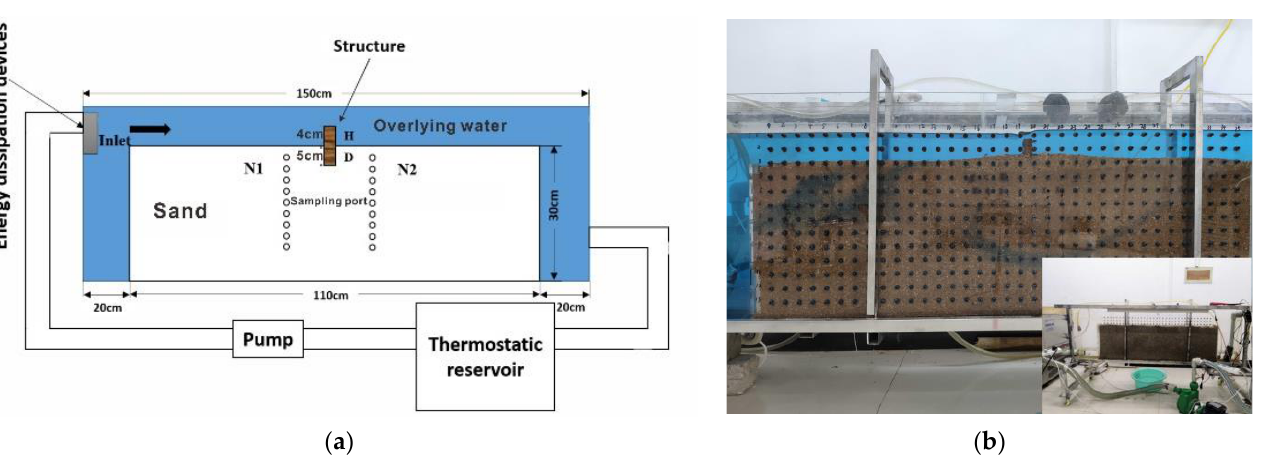
Figure 1. Schematic diagram of the flume experiment ( a ) revised from references [11] and [33] and the actual experimental flume diagram ( b ). The light gray and blue areas in ( a ) represent the parts filled with sand and water, respectively. The object is the enlarged flume with weir and the embedded is the overall peripheral structure design in ( b ).